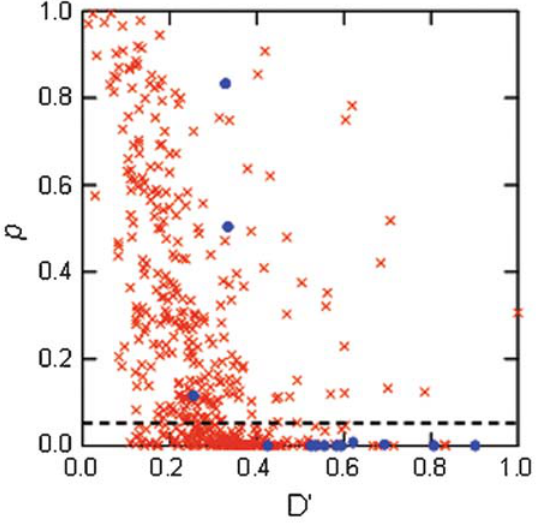
Figure 4. Linkage disequilibrium between pair-wise microsatellite loci in Scandinavian wolves. D 9 - and p -values are shown for locus-pairs located on the same (dots) and different (crosses) chromosomes. The dashed line indicates the p =0.05 significance level.